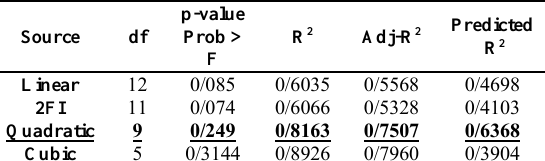
Table 4. lack of fit tests and model summary statistics